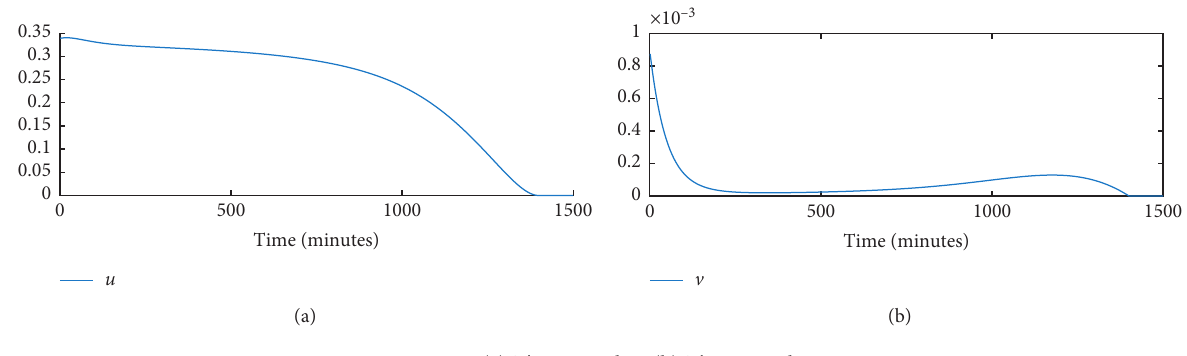
Figure 4: (a) The control u . (b) The control v